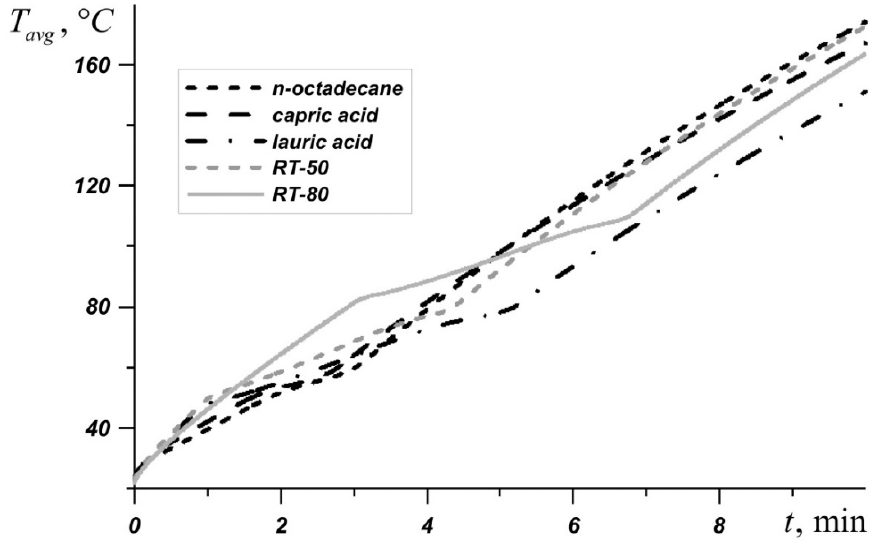
ff erent phase change materials